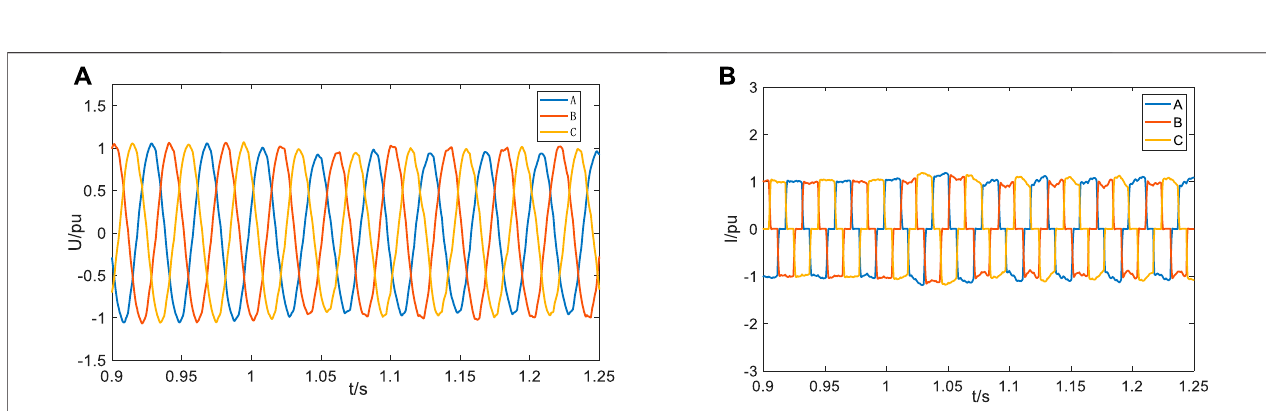
FIGURE 13 | Experimental waveform diagram of installing STATCOM/BESS: (A) AC voltage on the inverter side and (B) inverter current of the converter valve.